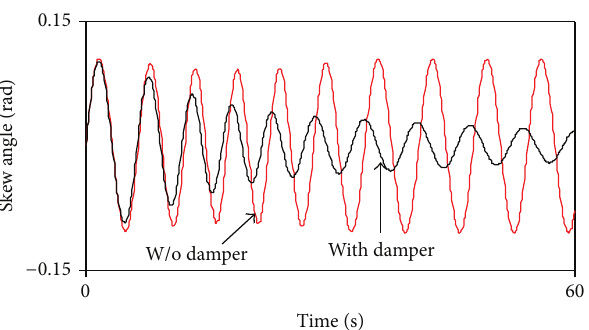
Figure 6: Spreader skew angle in the case 𝑚 = 20 tons, 𝛾 = 0.1 .